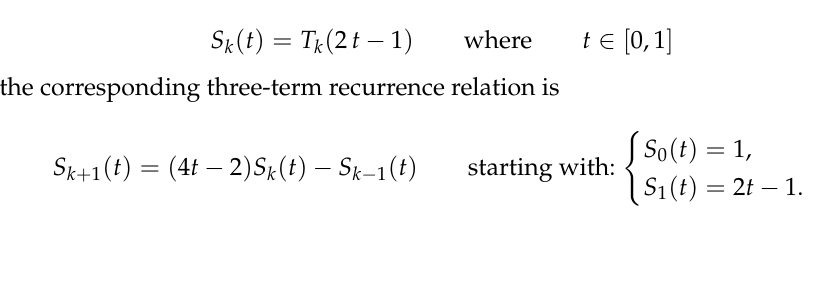
Figure 1. Functional f ( x , g ( x )) ( left plot) and its RL derivative D α choices of g ( x ) . Here, α = 0.8, x 0 = 1, f 0 = 1 and p =